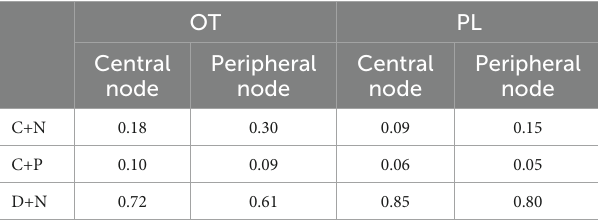
TABLE 7 Stable proportions of strategies in OT and PL